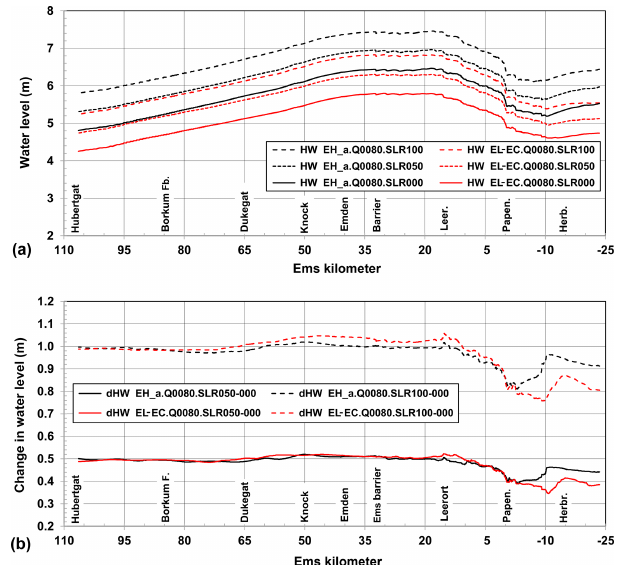
Figure 10. (a) Highest water levels along a longitudinal profile in the Ems estuary during EH_a (black lines) and EL (red lines) for SLR = 0cm (solid lines), SLR = 50cm (dotted lines) and SLR = 100cm (dashed lines) for an open storm surge barrier and Q = 80m 3 s − 1 . (b) Differences in the highest water levels between sim- ulations with and without SLR along the Ems estuary during EH_a (black lines) and EL (red lines) for Q = 80m 3 s − 1 (dashed lines for SLR = 100cm, solid lines for SLR = 50cm). The storm surge barrier is open.